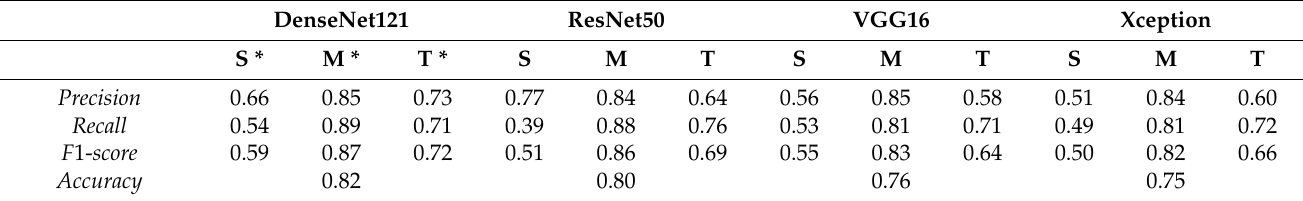
Table 2. Summary of measurable metrics for the selected deep learning models in the classification of off-target dicamba